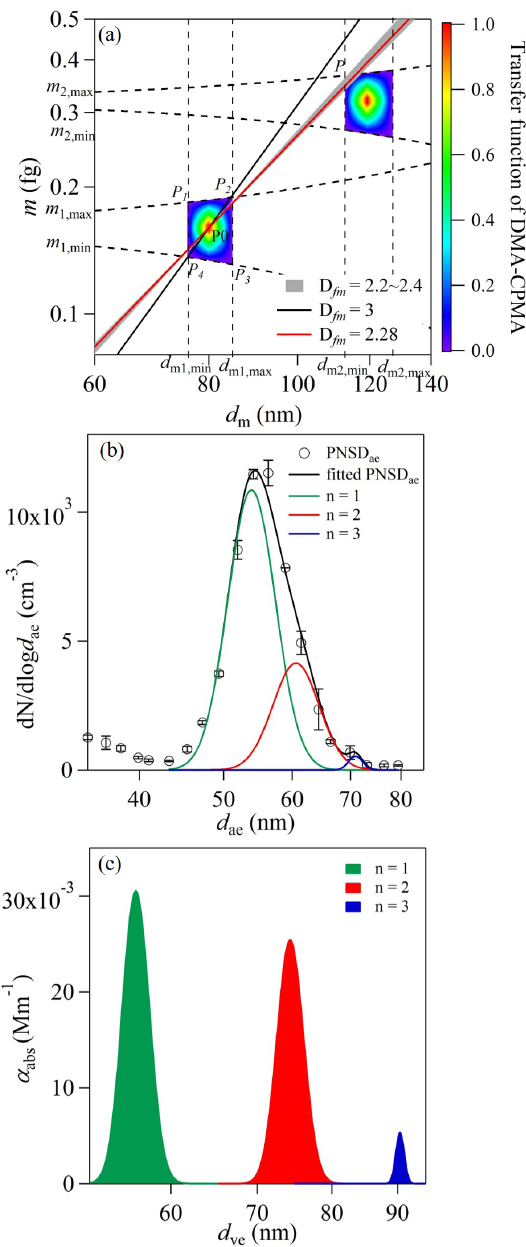
Figure 6. (a) The transfer functions of DMA–CPMA when se- lecting 200nm and 1.28fg particles. The following parameter set was employed for the calculations: d m 1 = 200nm, β DMA = 0 . 1, m 1 = 1 . 28fg, Q CPMA = 0 . 3Lmin − 1 and R m = 8. The solid red line is the generated soot particle population. (b) The aerodynamic size distribution of particles classified by DMA–CPMA. The cir- cles are data measured by AAC-CPC, and the solid line is the log- normally fitted distribution. (c) Contributions to light absorption of particles with a single charge calculated with Mie